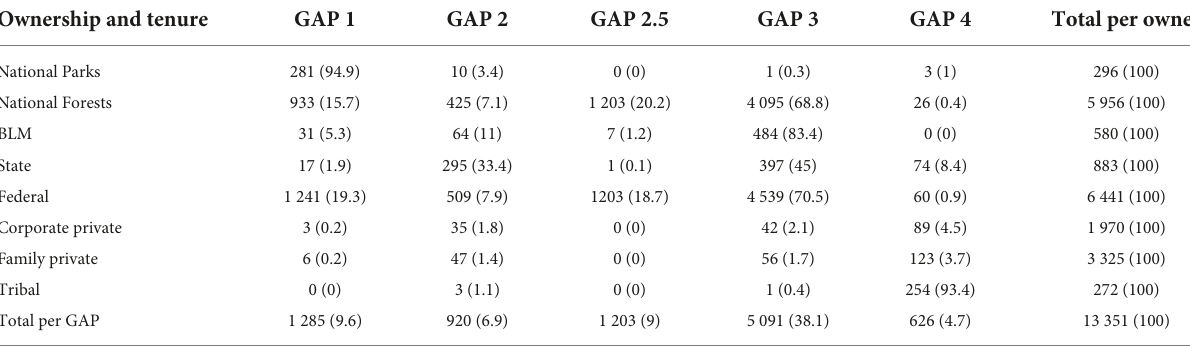
TABLE 5 Total-above ground living biomass within mature and old-growth forests ( × 1 M tons) by GAP and ownership.